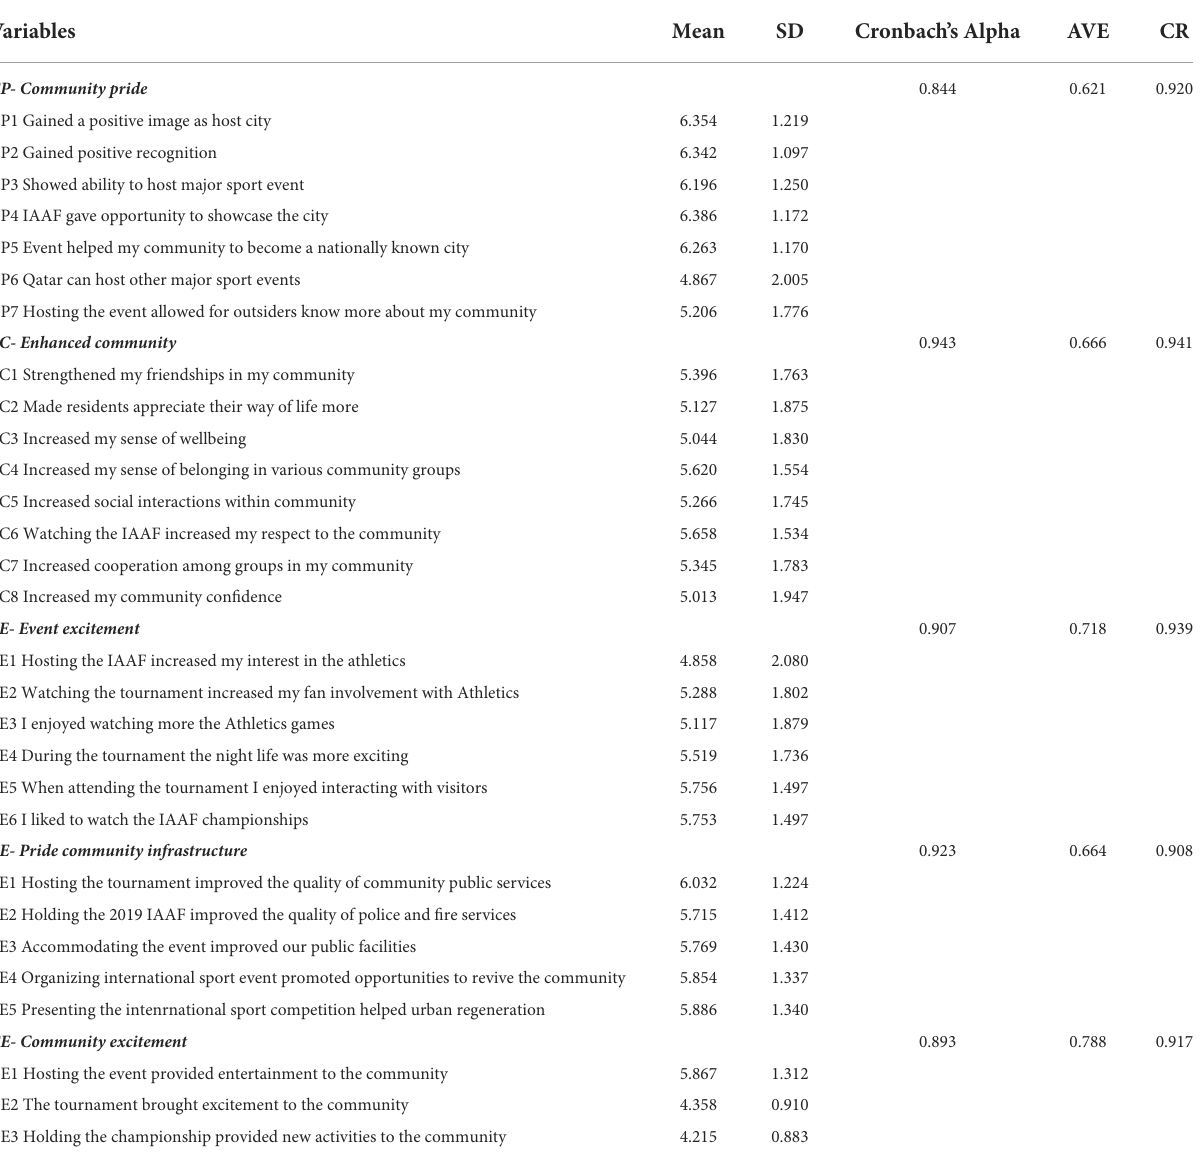
TABLE 1 Validity and reliability of the